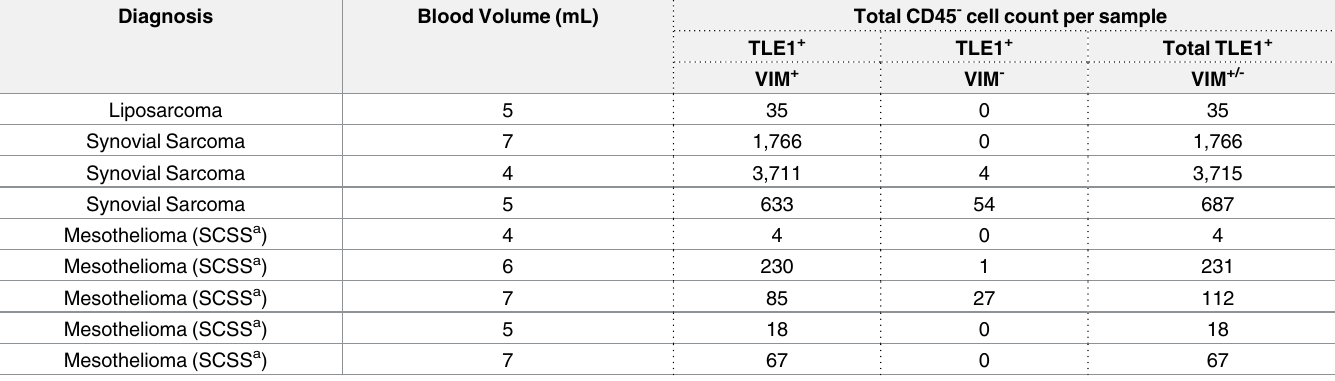
Table 3. Phenotypic characterization of putative CTCs with vimentin and